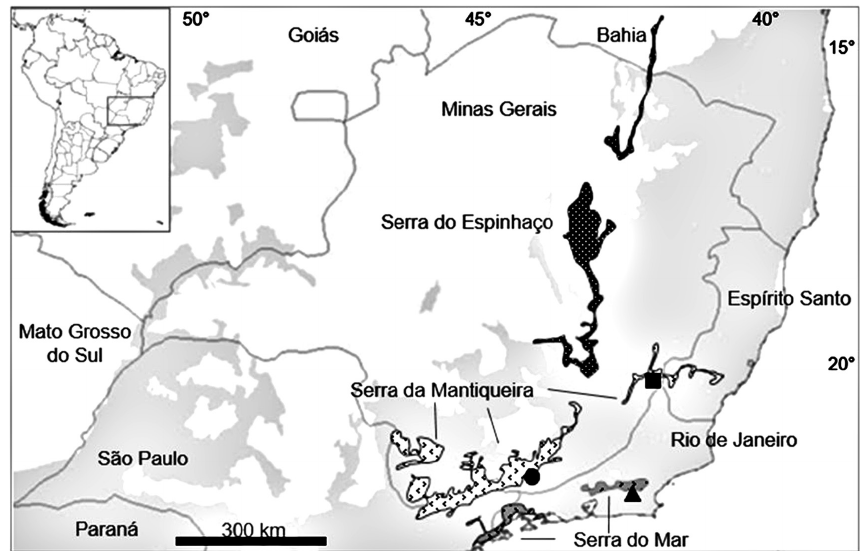
Figure 1. Collecting localities of P. lundi including the type locality (circle) and new locality of occurrence (square). Gray area corresponds to Atlantic Forest.